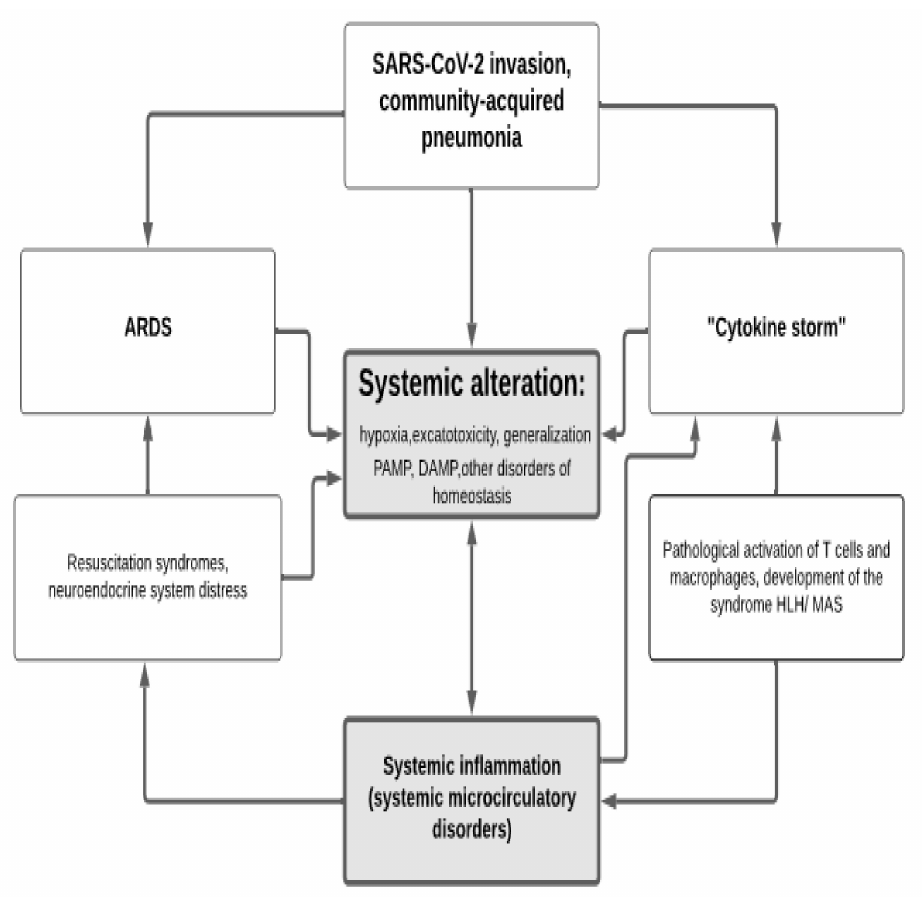
Figure 1. Transformation of classic inflammation in COVID-19 into systemic inflammation with the formation of a vicious pathogenetic circle. Three key mechanisms may be distinguished in the formation of a vicious pathogenetic circle and the development of a critical state in COVID-19: (1) the severity of ARDS (Acute Respiratory Distress Syndrome), which is linked to acute lung damage and systemic microcirculatory abnormalities, regardless of the primary focus of damage. Additionally, with the development of other resuscitation syndromes such as DIC and MODS, the phenomenon of systemic change promotes the onset of organ dysfunctions and coagulopathy. (2) During the development of microcirculatory diseases, DAMPs (damage-associated molecular pattern) and TF (Tissue Factor) and other hazardous products of tissue degradation are widespread. (3) The emergence of the “cytokine storm” phenomenon, which is linked to hemophagocytic lymphohistiocytosis (macrophage activation syndrome, MAS) and overproduction of cytokines in the focus of COVID-19 canonical inflammation, sharply increases with the generalization of pro-inflammatory tissue stress linked to